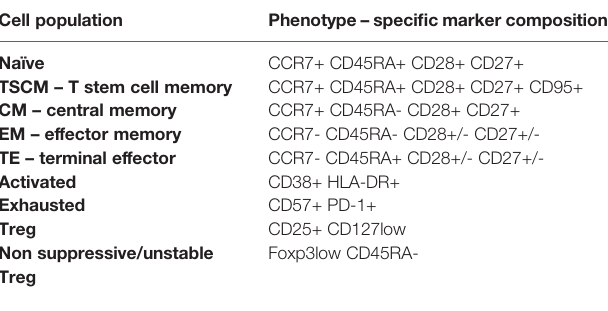
TABLE 2 | T cell phenotypes distinguished during manual and unsupervised analyses of CD4+ and CD8+ cells. Cell